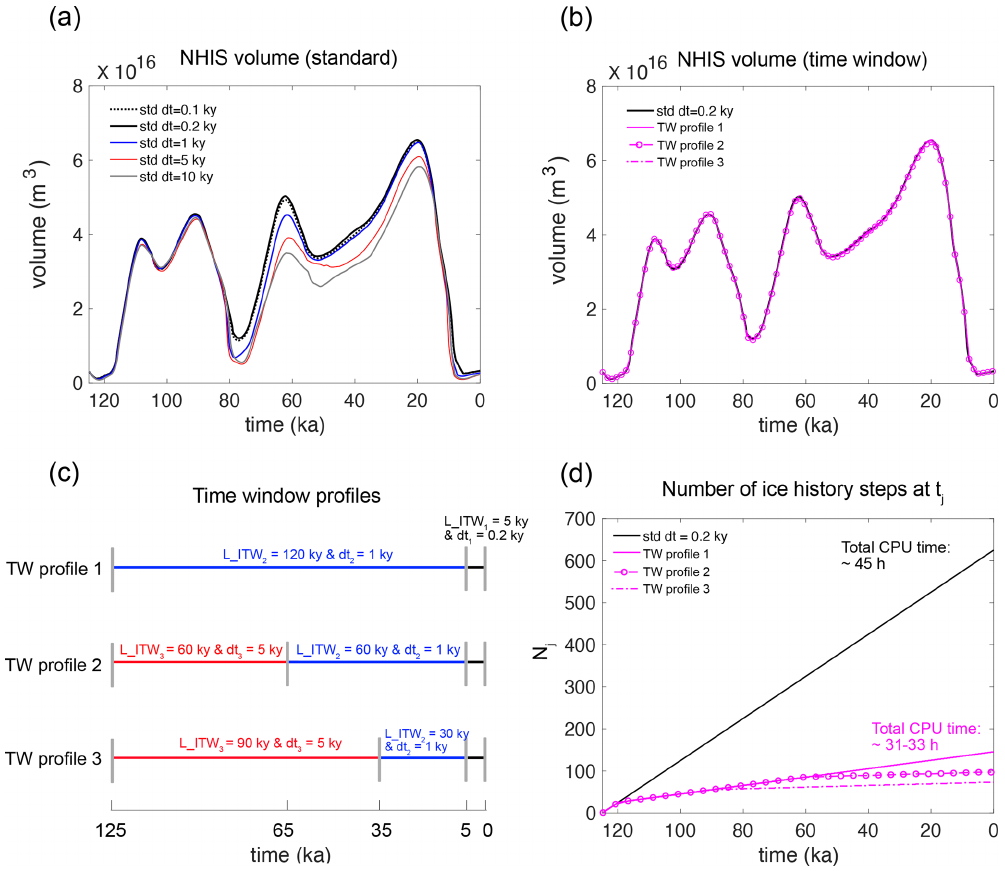
Figure 3. Modelled Northern Hemisphere ice-sheet volume through the last 125kyr from ice-sheet–sea-level coupled simulations. Volume variations in Northern Hemisphere ice sheets simulated in the coupled ice-sheet–sea-level simulations that incorporate (a) “standard”, uni- form time stepping (and thus coupling time interval) of 0.1kyr (dotted black line), 0.2kyr (black line), 1kyr (blue line), 5kyr (red line) and 10kyr (grey line). (b) Non-uniform time intervals assigned by the time windows of three different profiles (magenta lines) as schematically shown in (c) ; TW profile 1 applies two internal time windows, L _ITW 1 and L _ITW 2 , each of which covers 5 and 120kyr over the entire simulation with dt 1 = 200 years and dt 2 = 1kyr. TW profile 2 applies three internal time windows, L _ITW 1 – L _ITW 3 , each of which covers 5, 30 and 90kyr with dt 1 = 0 . 2, dt 2 = 1 and dt 3 = 5kyr, and TW profile 3 also applies three internal time steps, each of which covers 5, 60 and 60kyr with dt 1 = 0 . 2, dt 2 = 1 and dt 3 = 5kyr, respectively. Note that all three profiles assign the first internal time window ( L _ITW 1